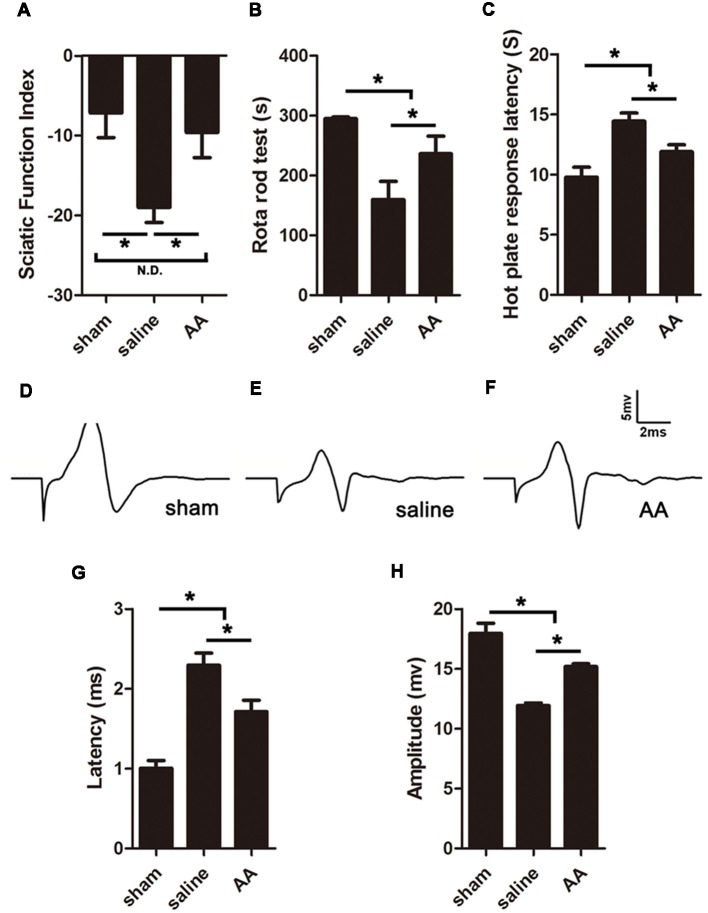
AA enhances functional recovery after sciatic nerve injury at 28 dpi. (A) Gait analysis results indicating the sciatic functional index (SFI). (B) Rotarod assay results showing the amount of time the mice remained on the rotating rod. (C) Hot plate test results showing withdrawal latency from a hot plate. (D–F) Respective compound muscle action potential (CMAP) images of the three groups. (G,H) Quantification of latencies and amplitudes of the CMAPs (n = 10, *P < 0.05; N.D. indicates no significant difference).